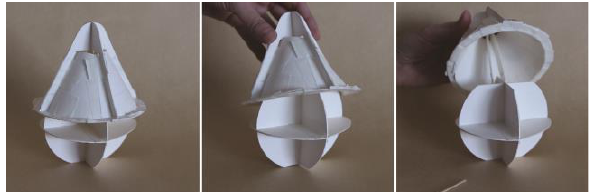
Figure 7 | Second paper prototype. The hat has the shape of a cone, rounded on top. The two elements are joint by providing the hat with two axes joint to the structure of the body though a pivot.